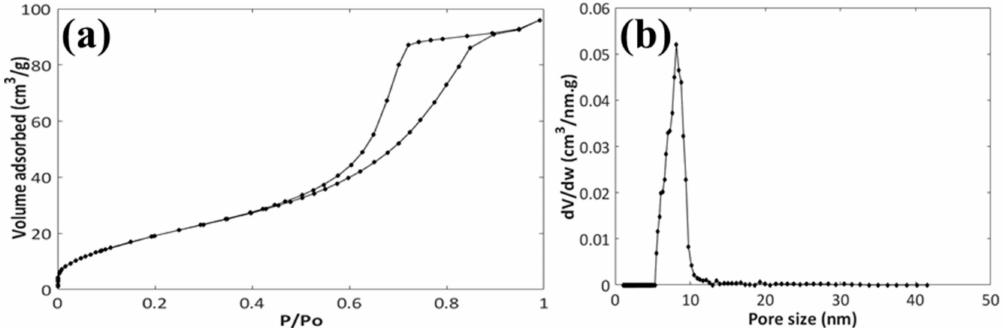
Figure 2. Nitrogen adsorption-desorption isotherms ( a ) and pore size distribution ( b ) of the mesoNsZnO carrier.